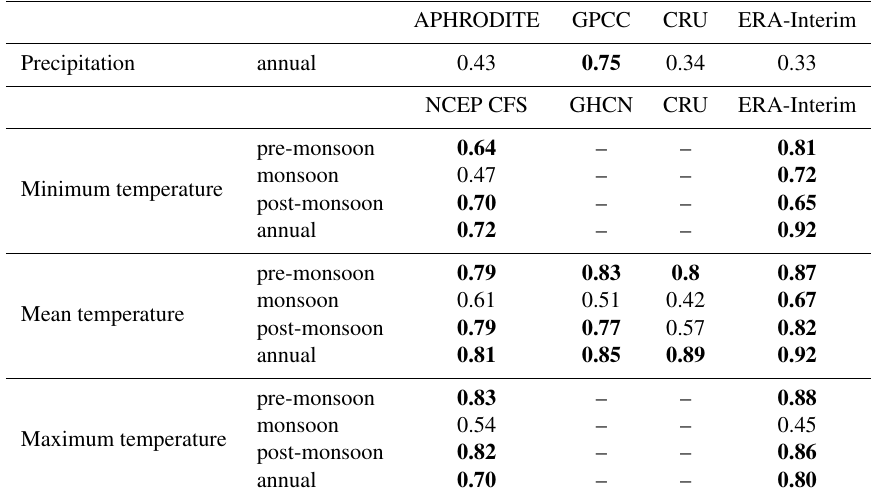
Table 1. Coefficients of correlation between precipitation and temperature time series recorded at Pyramid station for the 1994–2013 period and gridded and reanalysis datasets (pre-monsoon, monsoon, and post-monsoon seasons as the months of February–May, June–September, and October–January, respectively). Bold values are significant with p <